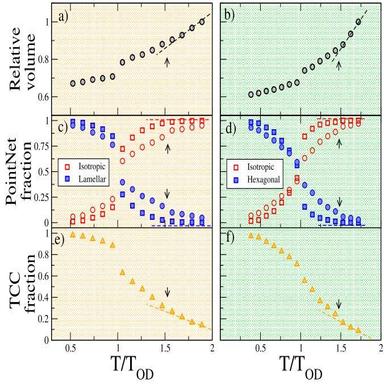
Analysis of various metrics across equilibrated trajectories relative to the order-disorder transition temperatures for lamellar (left column: subfigures a, c, e) and hexagonal (right column: subfigures b, d, f) systems. Subfigures (a) and (b) show the relative volume changes as a function of temperature. Subfigures (c) and (d) illustrate the fraction of particles classified by the neural network as ordered (blue filled symbols, circles for = 1.3, squares for = 2.0) and disordered (red empty symbols, circl